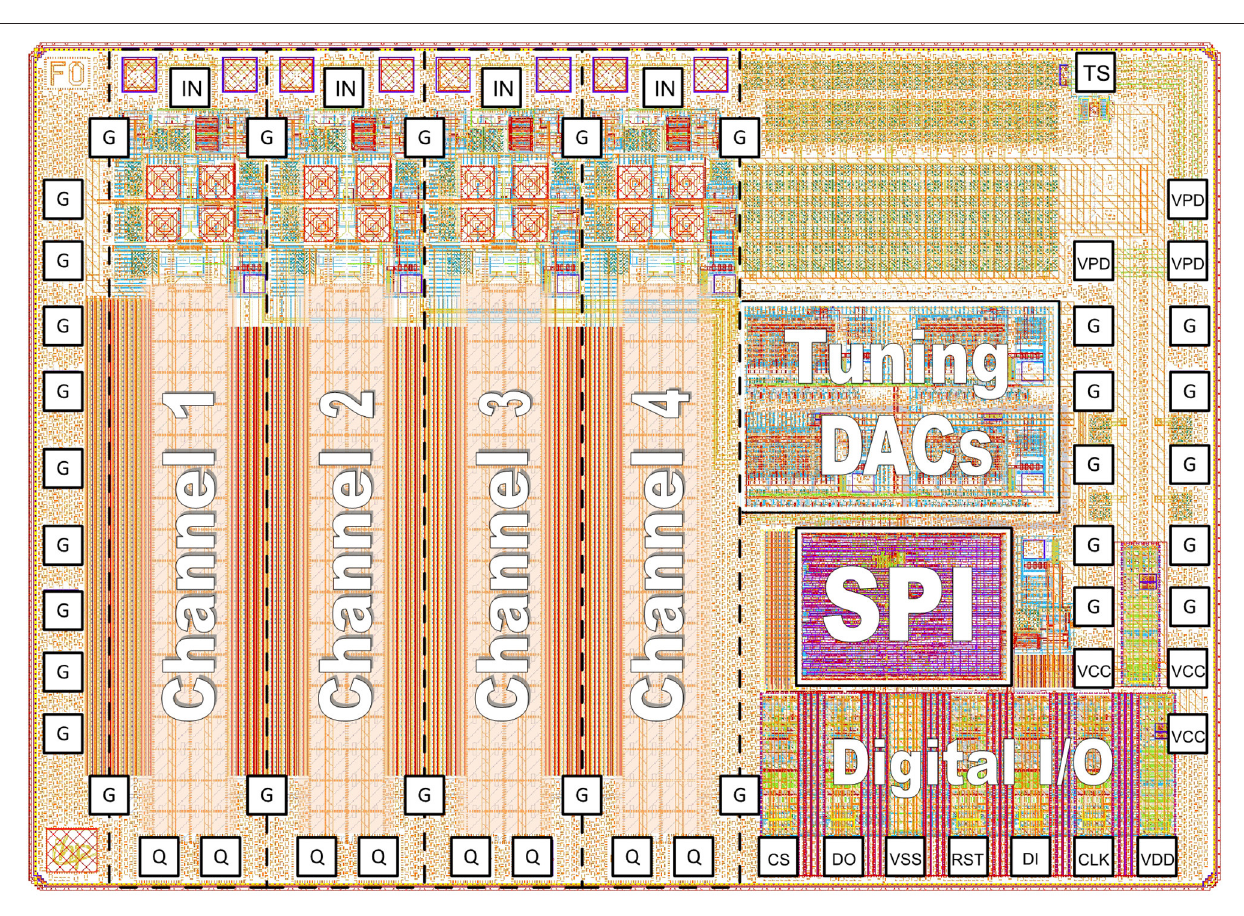
FIGURE 15 | A four-channel TIA IC